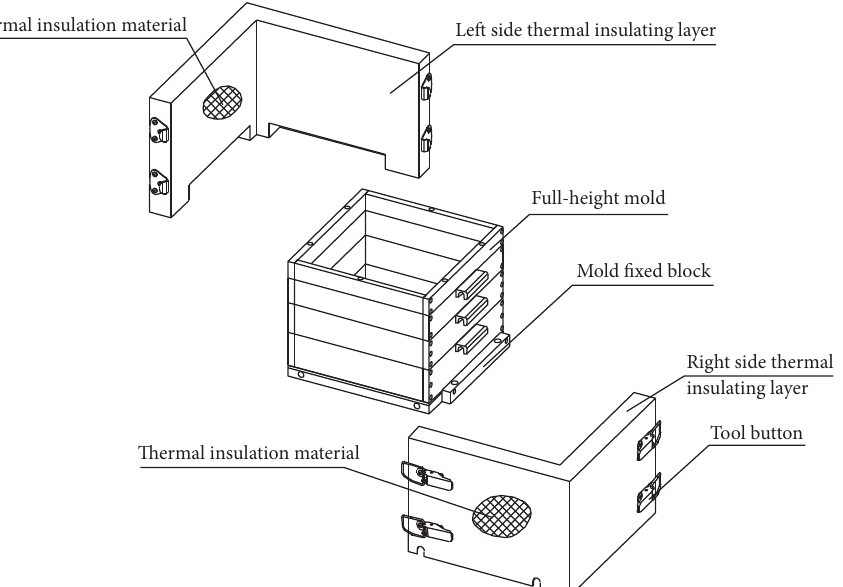
Figure 3: Schematic diagram of the left and right side thermal insulating layers and the full-height test mold.